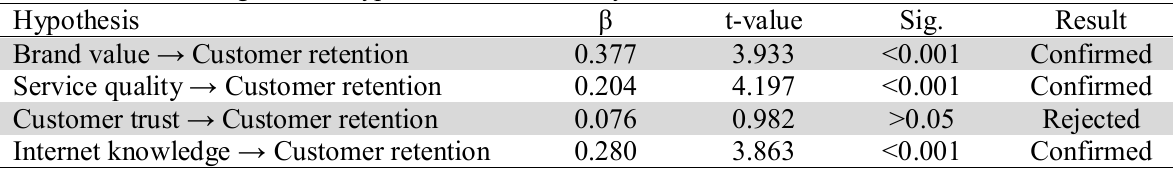
The results of testing various hypotheses of the survey